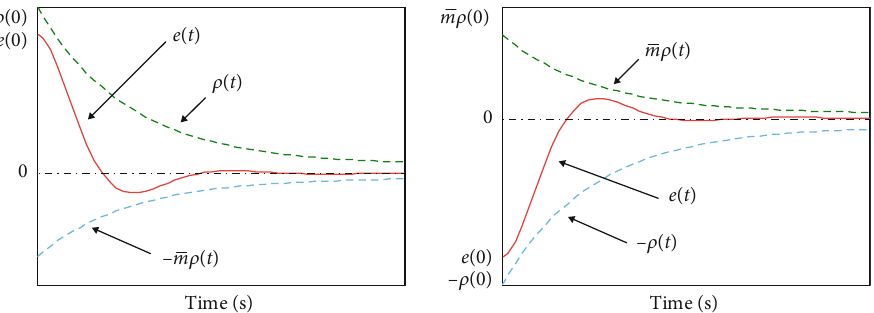
Figure 2: Graphical illustration of the traditional prescribed performance de fi nition (11): (a) e ð 0 Þ > 0 ; (b) e ð 0 Þ < 0